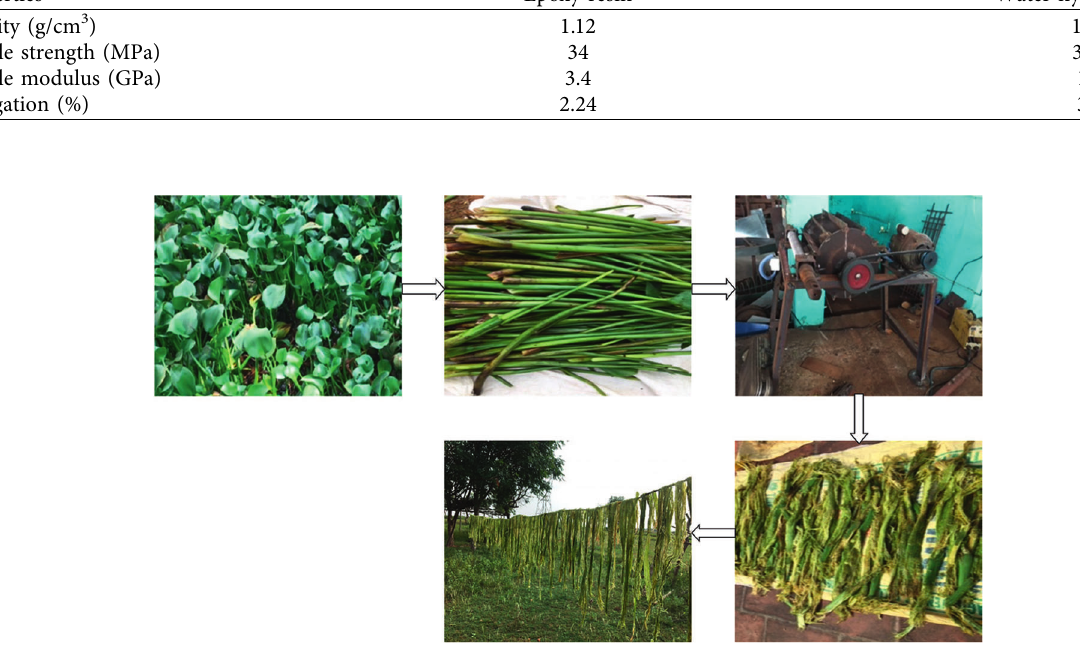
Figure 1: Extraction process of water hyacinth plant fibres.